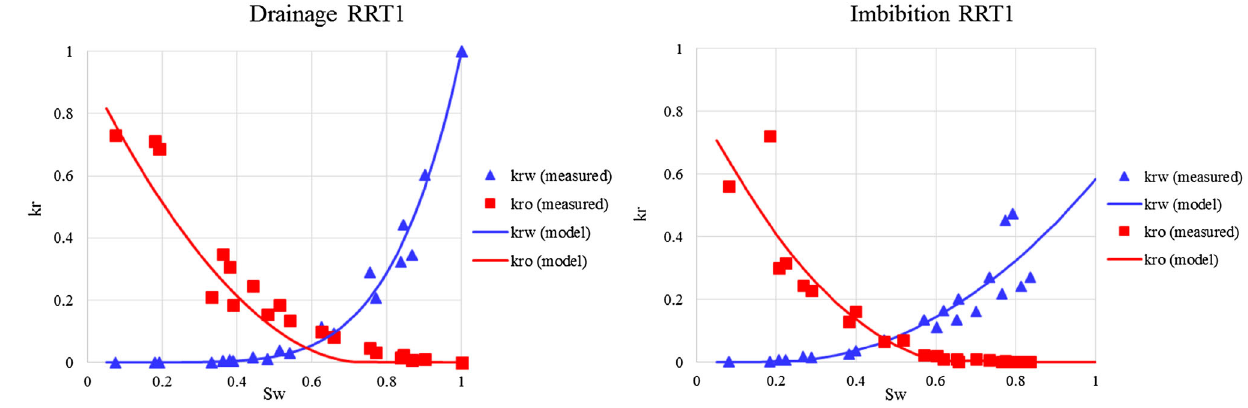
Fig. 20 Drainage and imbibition K r correlation for RRT 1